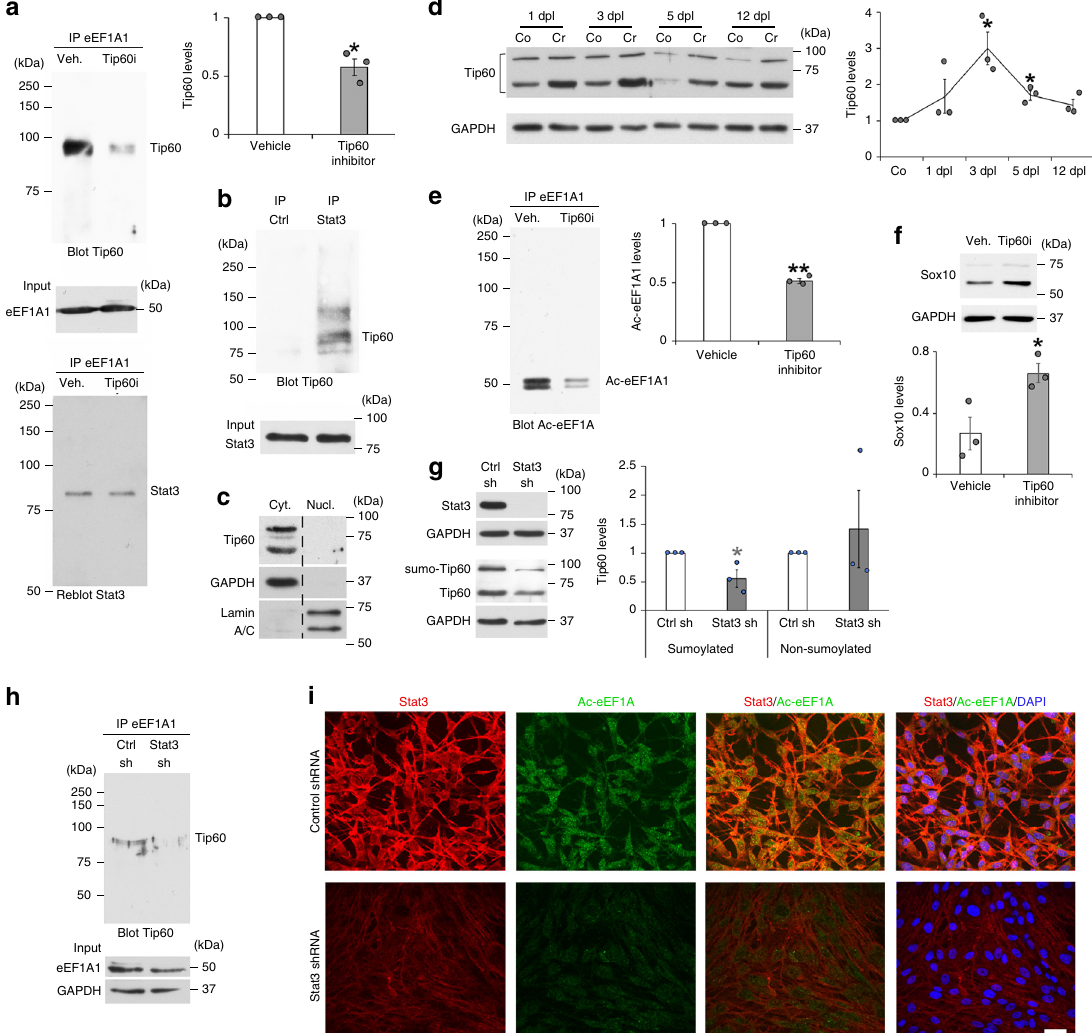
Fig. 5 Tip60 acetylates eEF1A1 in a Stat3-dependent manner. a , e eEF1A1 immunoprecipitation (IP) in lysates of SCs induced to de-differentiate for 1 day and treated with TH1864 (Tip60 inhibitor, Tip60i) or vehicle, and Tip60, Stat3 ( a ) or Ac-eEF1A ( e ) Western blot and quanti fi cation (normalized to eEF1A1) of Tip60 co-immunoprecipitated with eEF1A1 ( a ) or of Ac-eEF1A1 ( e ) in Tip60 inhibitor- compared to vehicle-treated SCs. b IP Stat3 or Flag (Ctrl) in lysates of SCs induced to de-differentiate for 1 day, Tip60 Western blot and Stat3 inputs. c Tip60, GAPDH (cytoplasmic marker) and Lamin A/C (nuclear marker) Western blots in cytoplasmic and nuclear fractions of SCs induced to de-differentiate for 1 day. Dashed lines: samples run on the same gel, but not on consecutive lanes. d Tip60 and GAPDH Western blots in lysates of crushed (Cr) and contralateral (Co) mouse sciatic nerves at 1-3-5-12dpl, and Tip60 quanti fi cation normalized to GAPDH in Cr compared to Co. f Sox10 and GAPDH Western blots in lysates of SCs induced to de-differentiate and treated with Tip60i or vehicle for 3 days and Sox10 quanti fi cation normalized to GAPDH. g Stat3 and Tip60 Western blots in SCs transduced with Stat3-speci fi c shRNA (Stat3 sh) or non-targeting control shRNA (Ctrl sh) lentiviruses and quanti fi cation of sumoylated (higher molecular weight) and non-sumoylated (lower molecular weight) Tip60 isoforms normalized to GAPDH. h eEF1A1 IP and Tip60 Western blot in SCs transduced with Stat3 sh or Ctrl sh lentiviruses. i Stat3 and Ac-eEF1A co-immuno fl uorescence and DAPI labeling in primary SCs transduced with Stat3 sh or Ctrl sh lentiviruses and induced to de-differentiate for 2 days. Scale bar: 20 µ m. Data presented as mean values± SEM. Unpaired ( f ) or paired ( a , d , e , g ) one-tailed (gray asterisk) or two- tailed (black asterisks) Student ’ s t -tests. P values = 0.029197 ( a ), 0.139771 ( d , 1dpl), 0.047935 ( d , 3dpl), 0.030298 ( d , 5dpl), 0.061845 ( d , 12dpl), 0.001796 ( e ), 0.033551 ( f ), 0.047979 ( g , sumoylated), 0.300207 ( g , non-sumoylated). N = 3 independent experiments or 3 animals per time-point. For each panel, representative images of 3 independent experiments are shown. Source data are provided as a Source Data fi